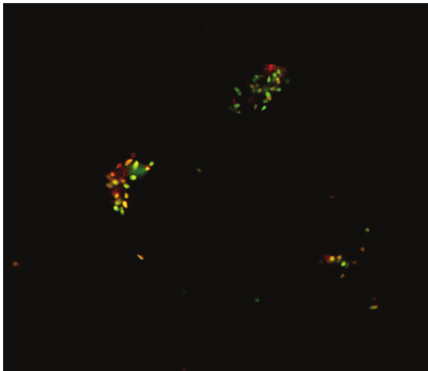
Figure 1: Fluorescence microscopy of acridine orange destained cells shows that spermatozoa displaying green fluorescence were considered to be with normal DNA content, whereas sperms displaying a spectrum of yellow-orange to red fluorescence were considered to be with damaged DNA. Original magnification ×